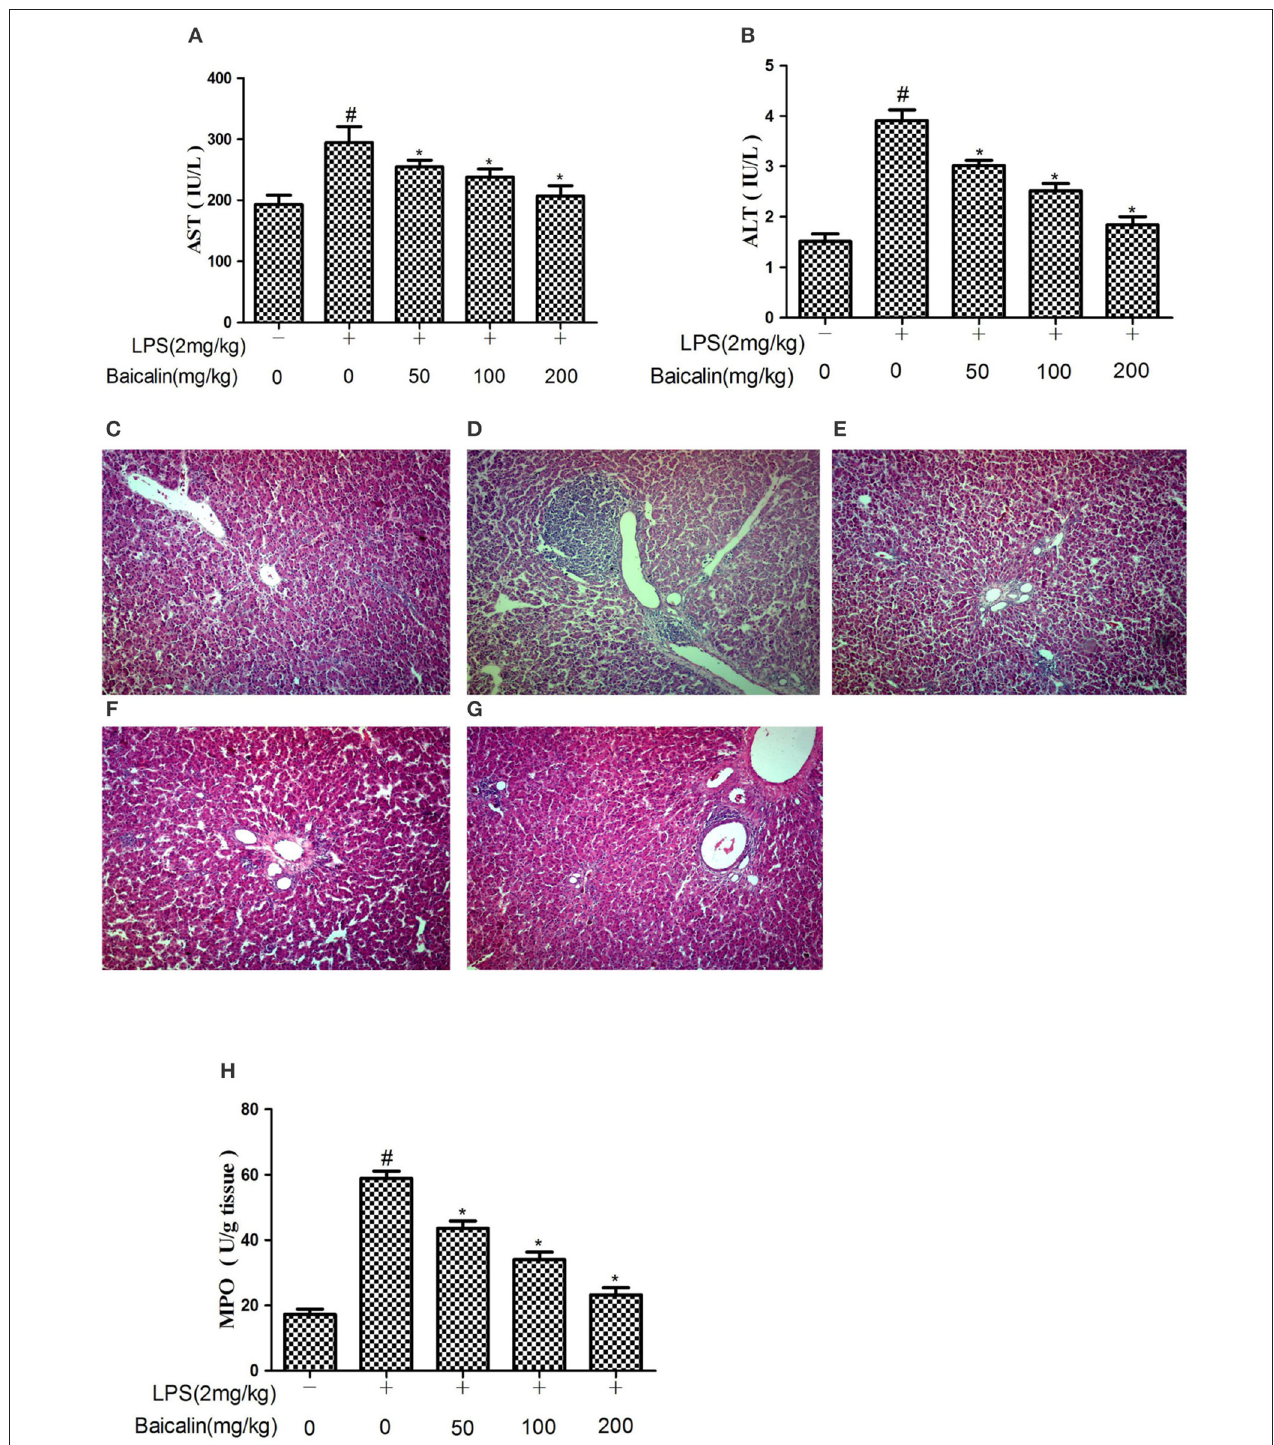
FIGURE 2 | Baicalin pretreatment alleviated LPS-induced liver inflammation. Effects of Baicalin on LPS-induced serum AST (A) and ALT (B) levels. Histopathological changes in liver after LPS stimulation (HE, × 100). (C) control group, (D) LPS group, (E–G) Baicalin (50, 100, 200mg/kg BW) + LPS groups. And effects of Baicalin on LPS-induced MPO activity in liver (H) . Data are expressed as the mean ± SD . ( n = 10). * P < 0.05vs. LPS group; # P < 0.05vs. control group.